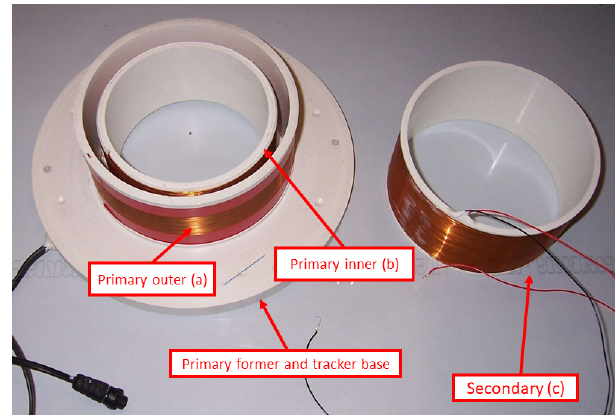
Figure 5. Coaxial transformer